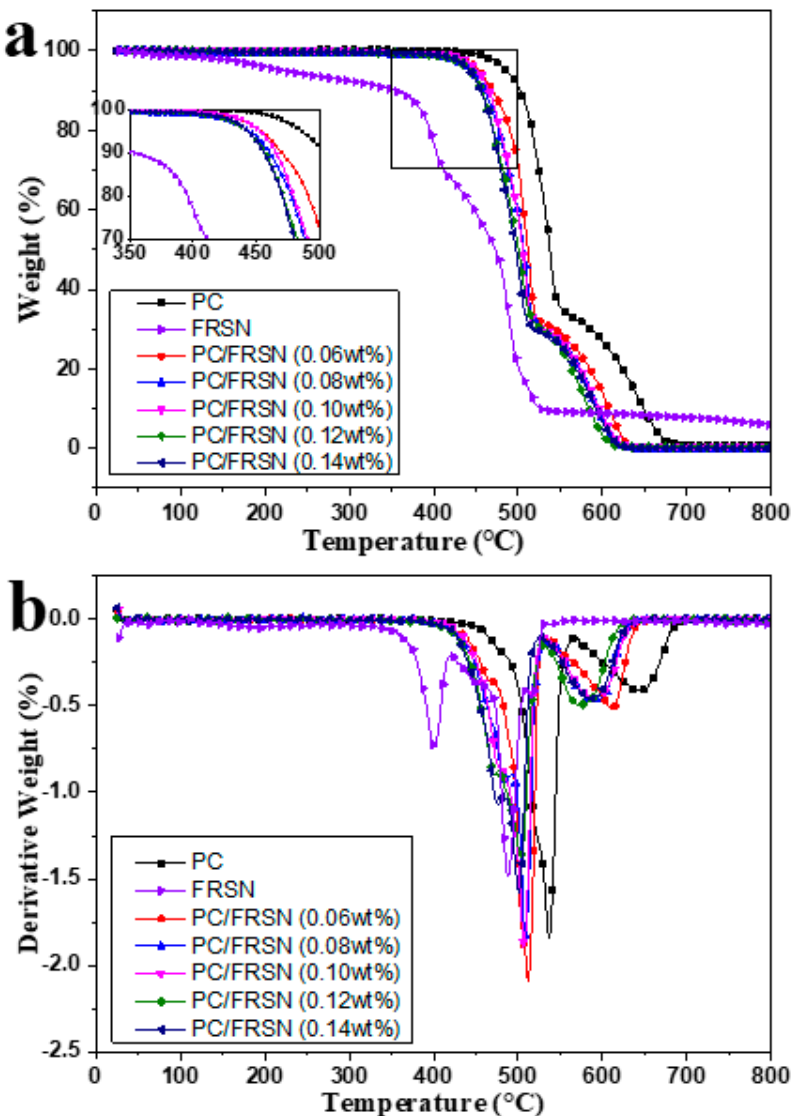
Figure 3. ( a ) TG and ( b ) DTG curves of PC composites, neat PC and FRSN under air atmosphere.